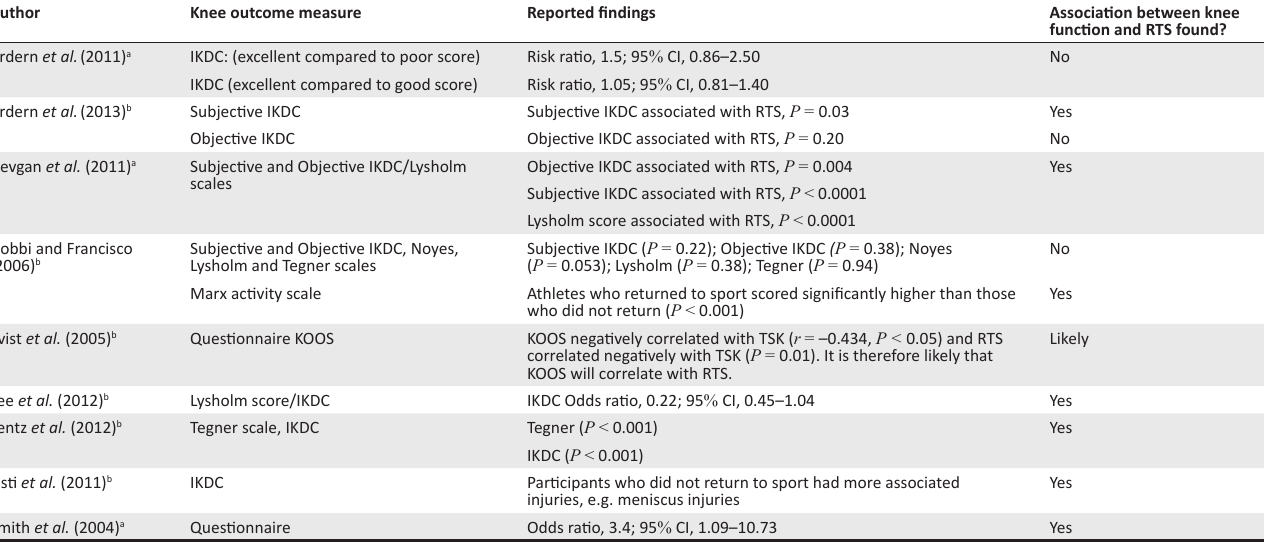
TABLE 5: Association of self-reported knee function/integrity with return to